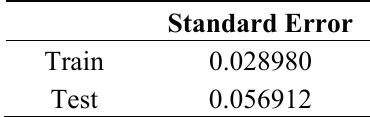
Table 3. The GBT classification’s standard error.